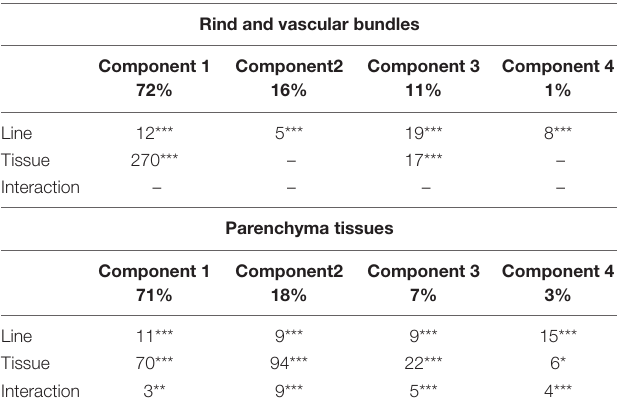
Variance analysis. Effects of inbred lines and tissues on the principal components. F value and significance. * , ** , *** means that the probability was below 5%, 1% and 0.1%,